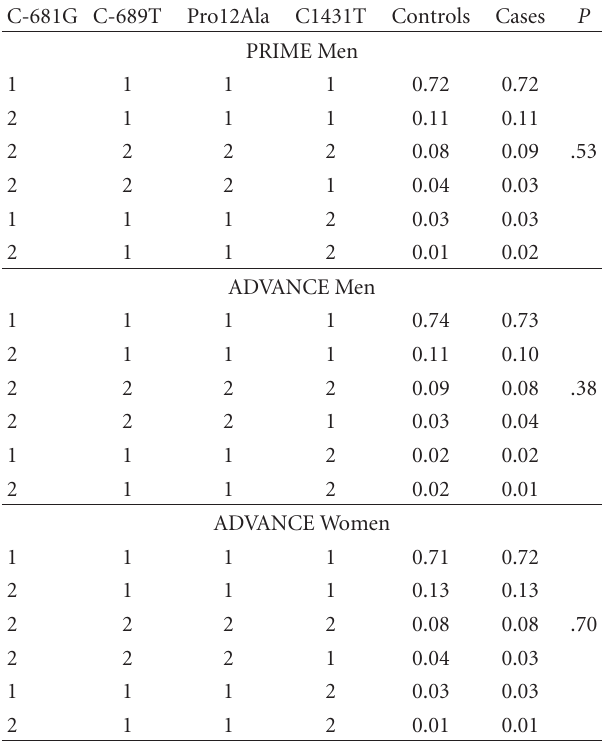
Table 3: Estimate of PPARG haplotype frequencies in cases and